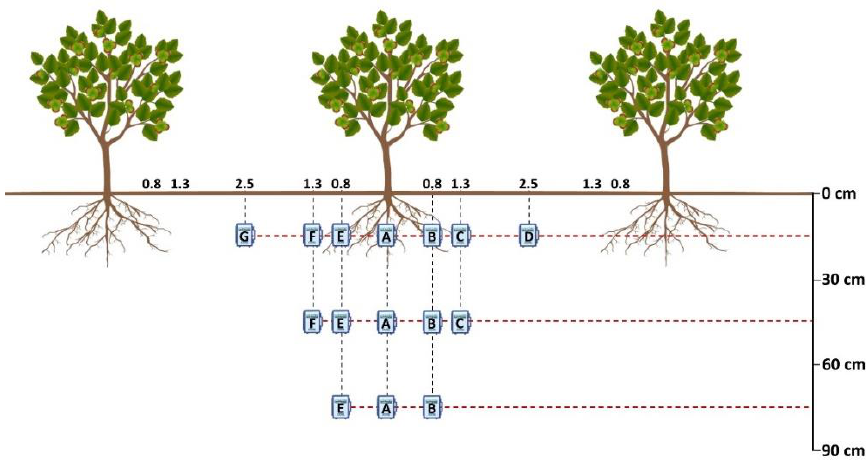
Figure 4. Watermark sensor placement at sites S1 and S2. Positions: A — under the trunk, B/E — 0.8 m from the trunk, C/F — 1.3 m from the trunk, and D/G — 2.5 m from the trunk.